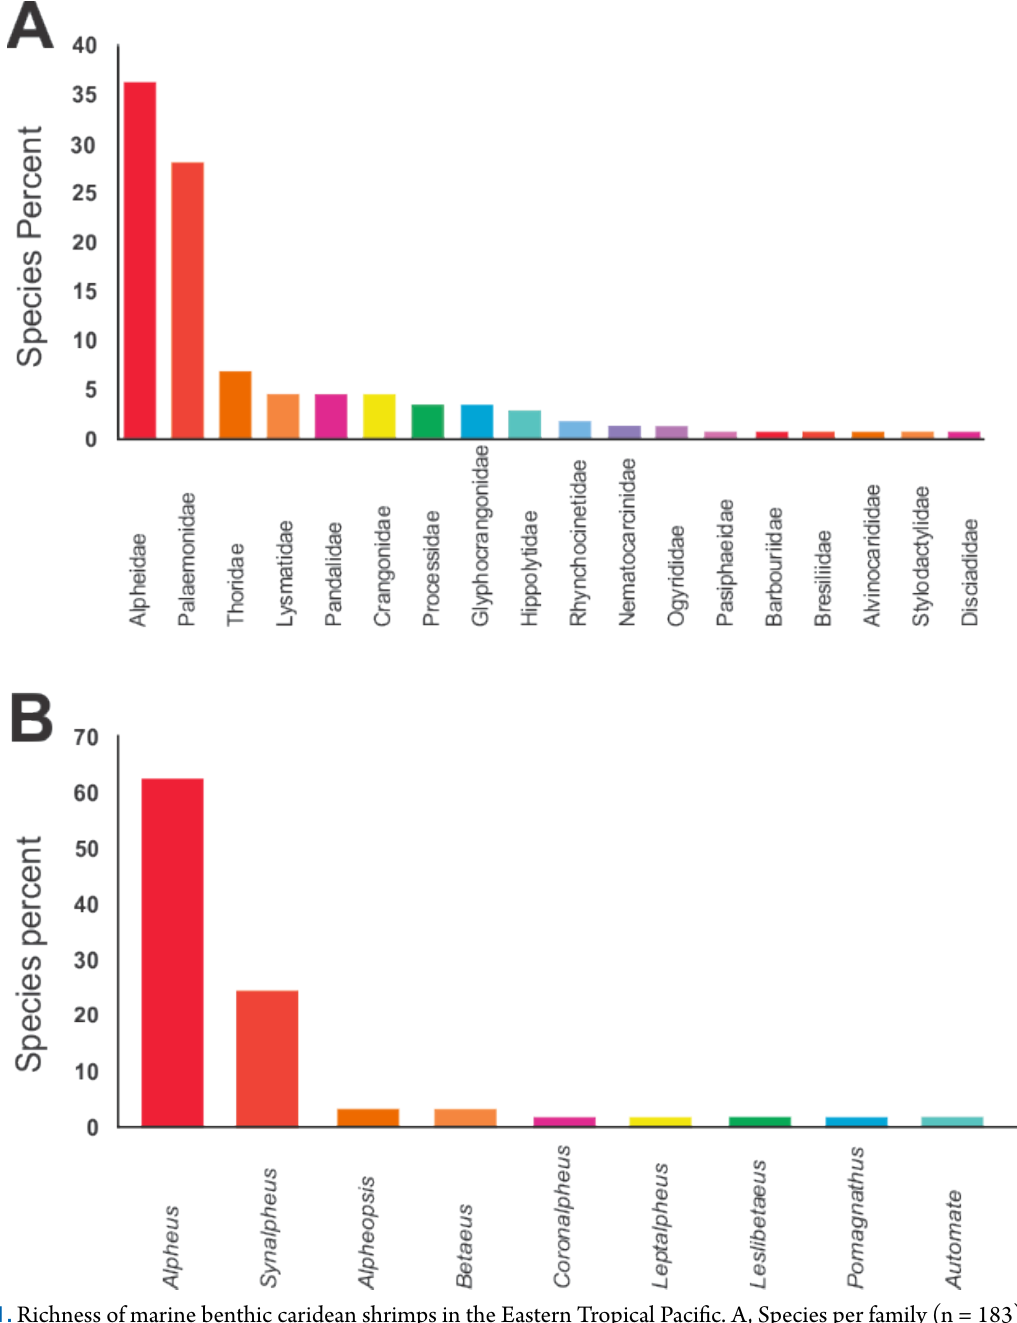
Figure 1. Richness of marine benthic caridean shrimps in the Eastern Tropical Pacific. A, Species per family (n = 183). B, Species per genera of Alpheidae (n =